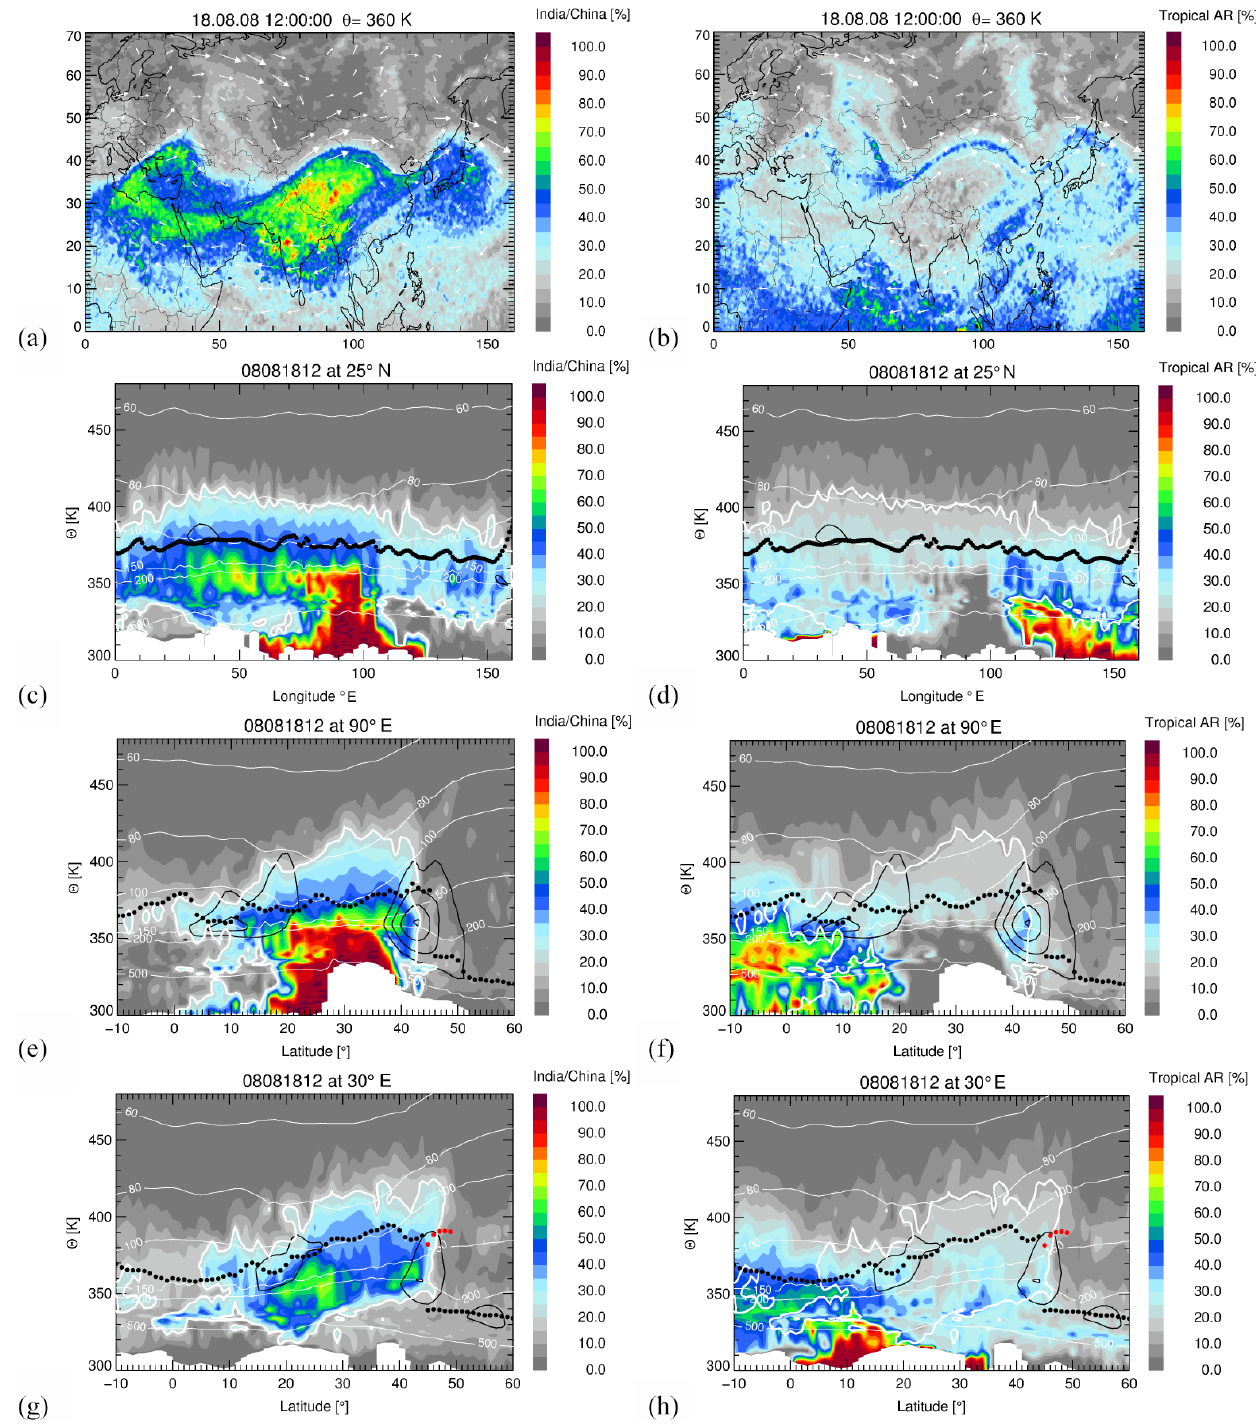
Figure 2. Horizontal distribution of the fraction of air originating in India/China (a, c, e, g) and in tropical adjacent regions (b, d, f, h) at 360K potential temperature, longitude–theta cross sections at 25 ◦ N and latitude–theta cross sections at 90 ◦ E (eastern part of the anticyclone) and 30 ◦ E (western part of the anticyclone) on 18 August 2008. The horizontal winds are indicated by white arrows (maps) or by black thin lines (cross sections) (shown are 30, 40, 50, and 60ms − 1 ). The primary thermal tropopause is marked by black dots, the secondary thermal tropopause by red dots, and the levels of pressure are marked by thin white lines. The contour line of 20% of the India/China tracer is shown by thick white lines (cross